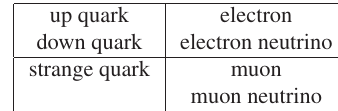
Table 2. Particles of matter 1964.